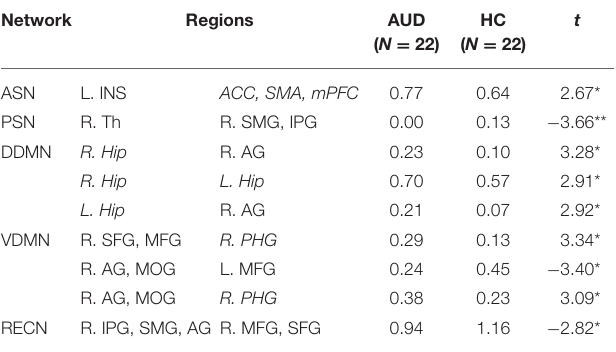
TABLE 3 | Difference in gray matter volume in each network between the groups. Network Region